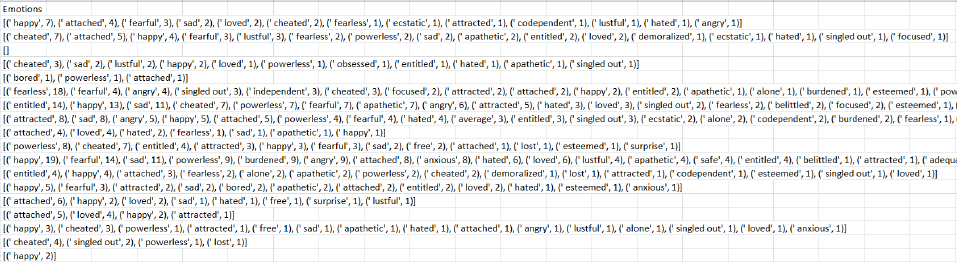
Figure 7. Snapshot of the “emotions” column from the review dataset.